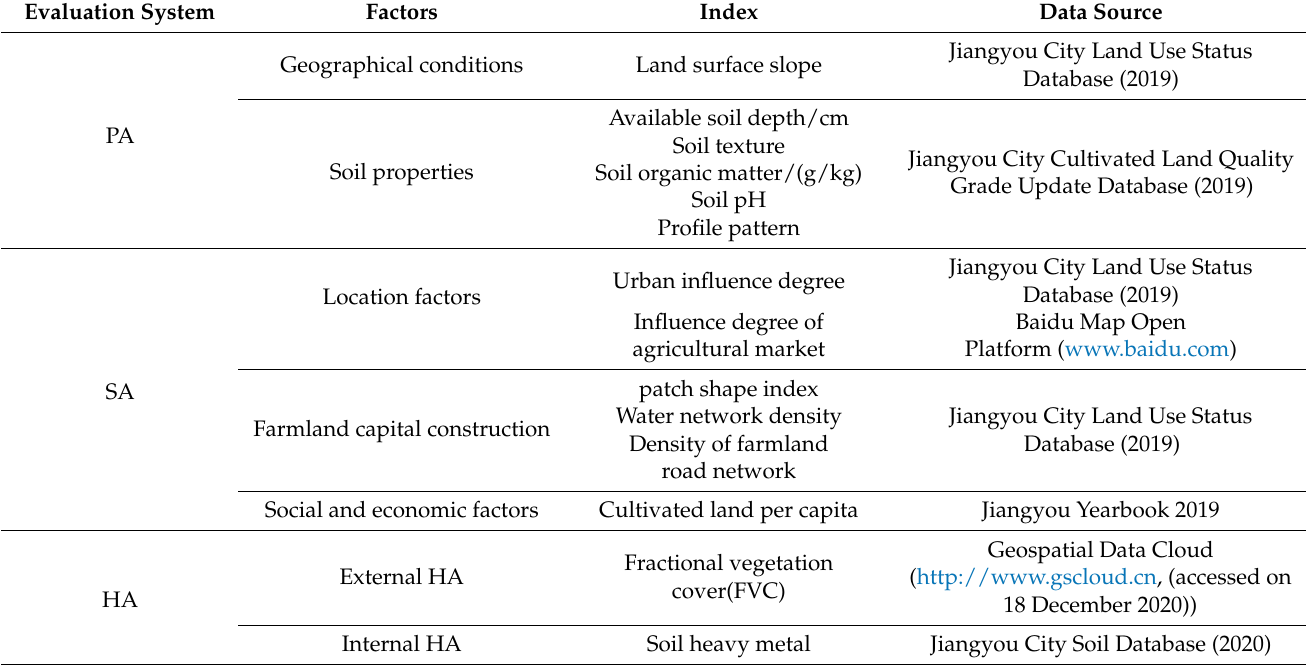
Table 1. Dataset description and